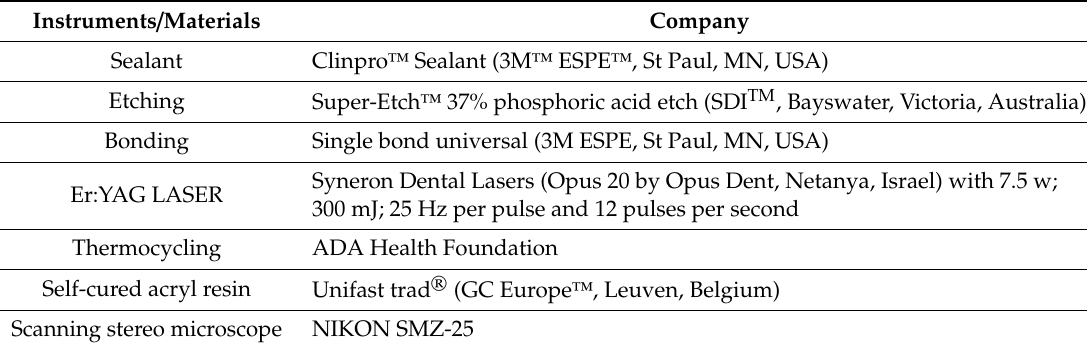
Table 1. Materials and instruments used in the present study.